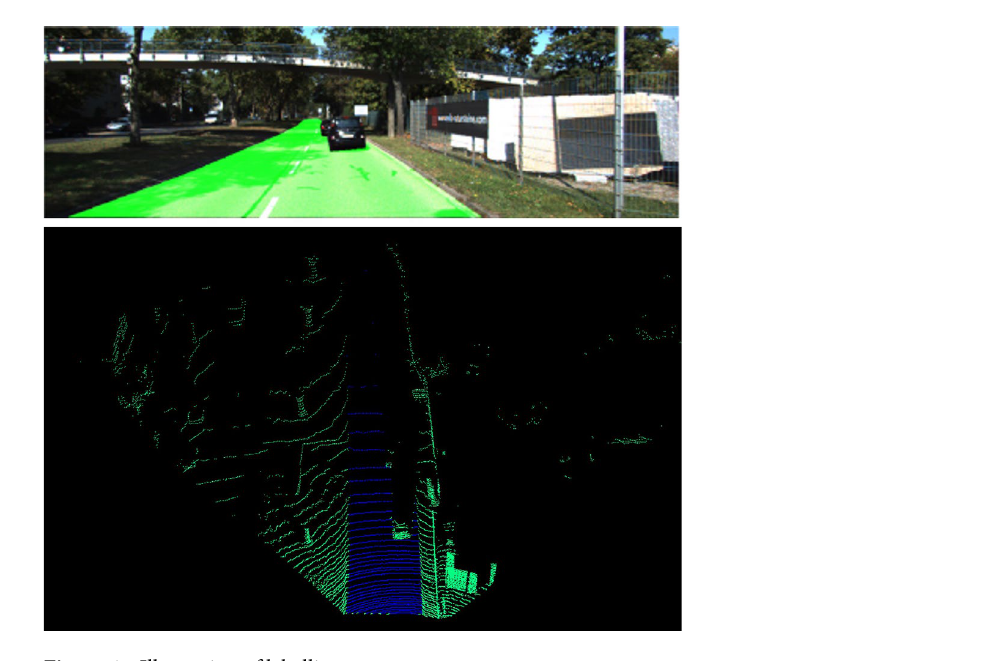
Figure 4. Illustration of